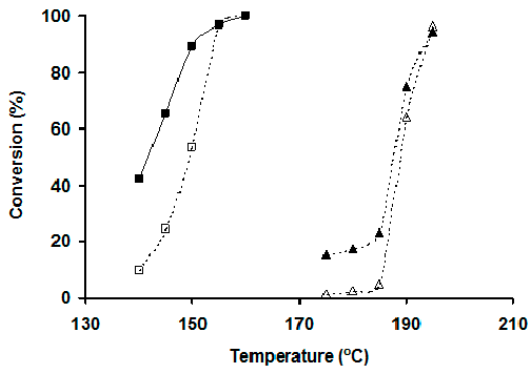
Figure 4. Light-off curves for A1000-Pt at two different toluene concentrations in the feeding gas: 0.10 vol.% (squares) and 0.45 vol.% (triangles). Open symbols: conversion to CO 2 . Closed symbols: conversion of toluene ( Q = 3.6 L h − 1 , 0.10 g catalyst ). Figure